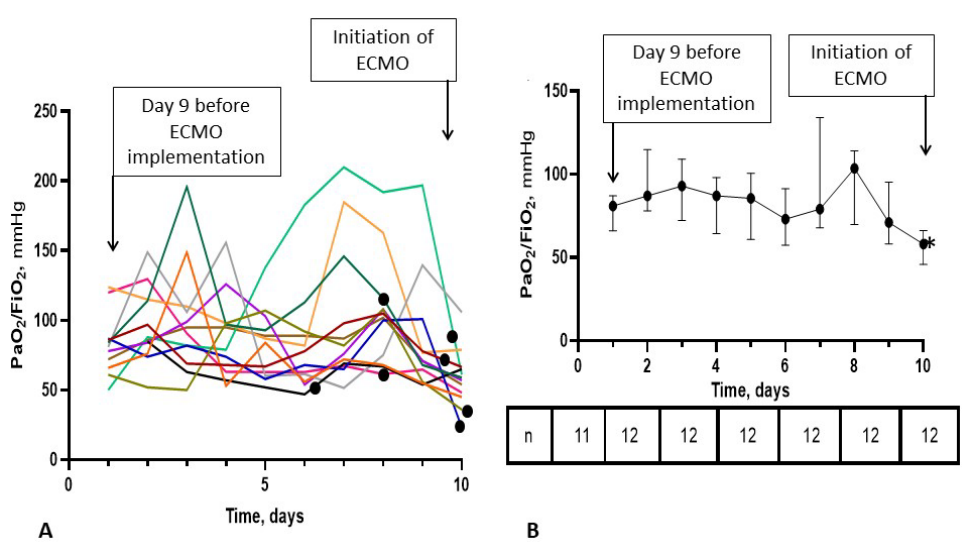
Figure 3. Individual and median PaO 2 /FiO 2 ratios during the 10 days before ECMO implementation in the 12 patients included in the ECMO-after group. Panel ( A ) represents PaO 2 /FiO 2 ratios of individual patients during the 9 days preceding ECMO initiation and the day of ECMO initiation (corresponding arrows). Data is missing in one patient on day 9 before ECMO initiation. Black dots in panel A represent patients with a diagnosis of bacterial pneumonia 48 h before or after the day of ECMO initiation. These were placed at different time points to avoid overlap with other curves. Panel ( B ) represents median PaO 2 /FiO 2 ratios and interquartile ranges as vertical bars. * Significant difference in day10 (days of ECMO implementation) compared to day 2, 3, 4, 7, 8 by Freedman tests for paired samples.